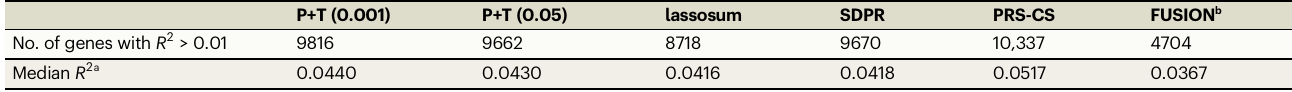
Table 1 | Test R 2 in n = 315 whole blood tissue samples from GTEx V8 P+T (0.001) P+T (0.05) No. of genes with R 2 > 0.01